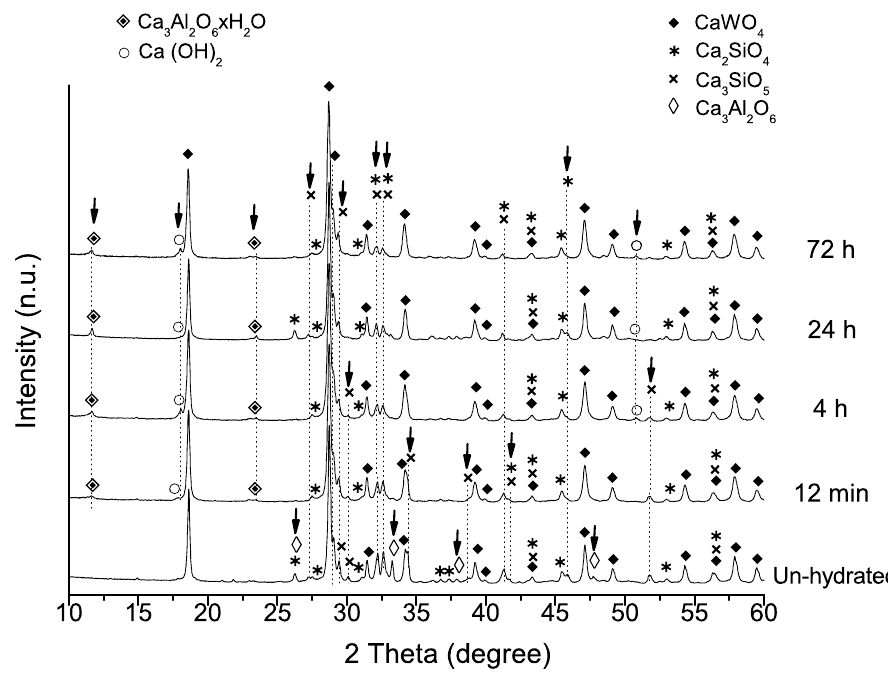
Figure 6. XRD patters of the un-hydrated MTA Repair HP and set material after 12 min, 4 h, 24 h, and 72 h. Black arrows indicate significant variations of detected phases with increasing time of the setting process.